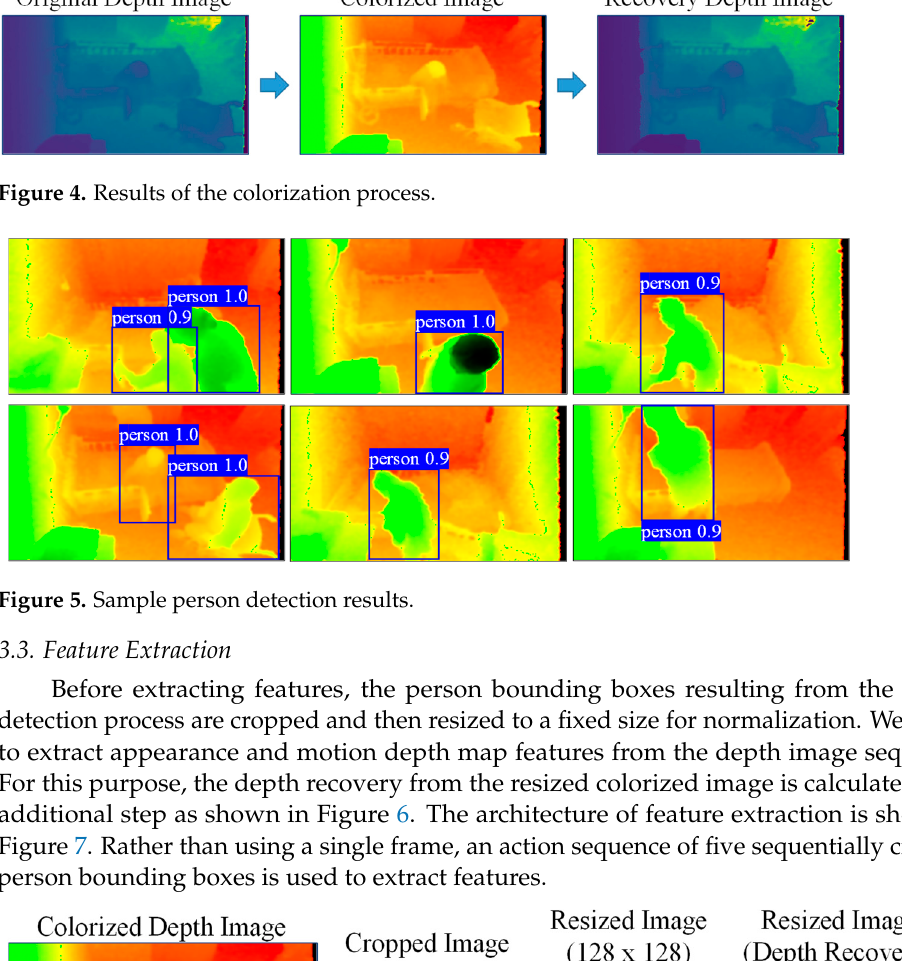
Figure 7. The architecture of feature extraction. 3.4. Action Recognition With HMM This section defines each action recognized in our system, calculates HMM parame- ters and probability measures, and provides HMM prediction procedures. 3.4.1. Action Definitions This experiment is designed to recognize five actions: ‘Transition’, ‘Seated in the wheelchair’, ‘Standing’, ‘Sitting’, and ‘Lying’. Specific action images are shown in Figure